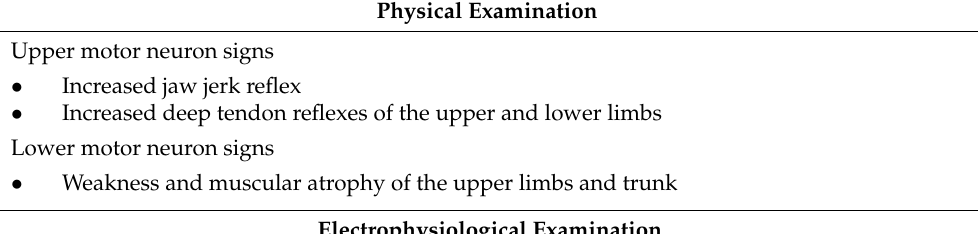
Table 1. Patient’s Clinical